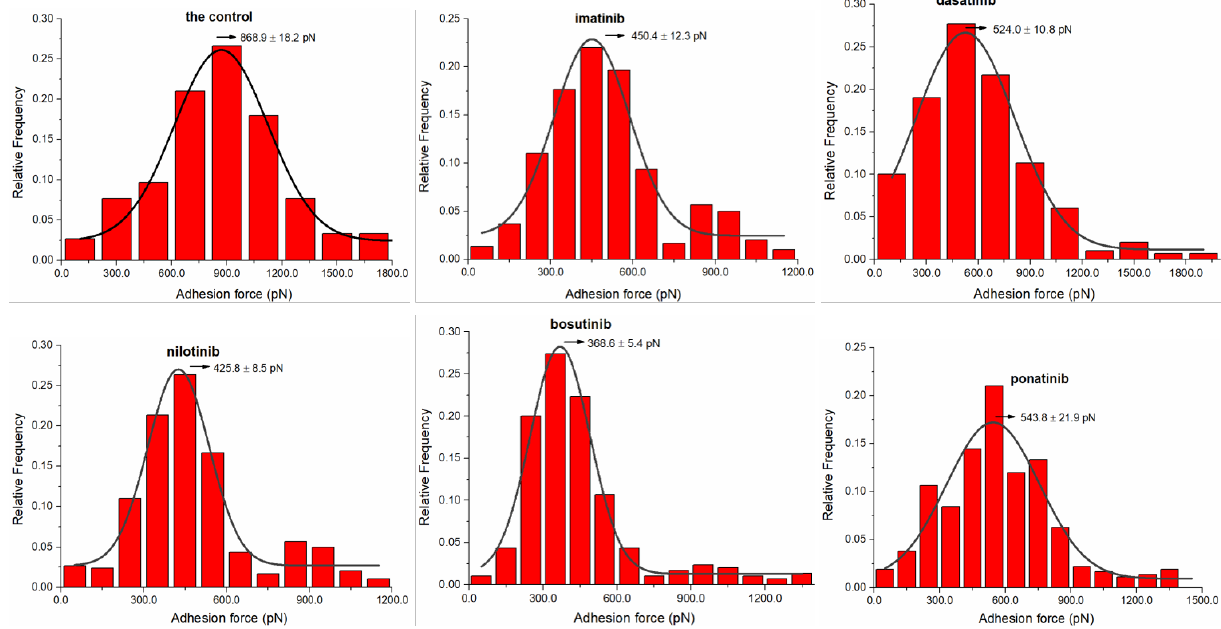
Figure 2. Adhesion force – frequency distribution histograms with Gaussian fitting curves recorded between HSA pairs in the control and TKIs.